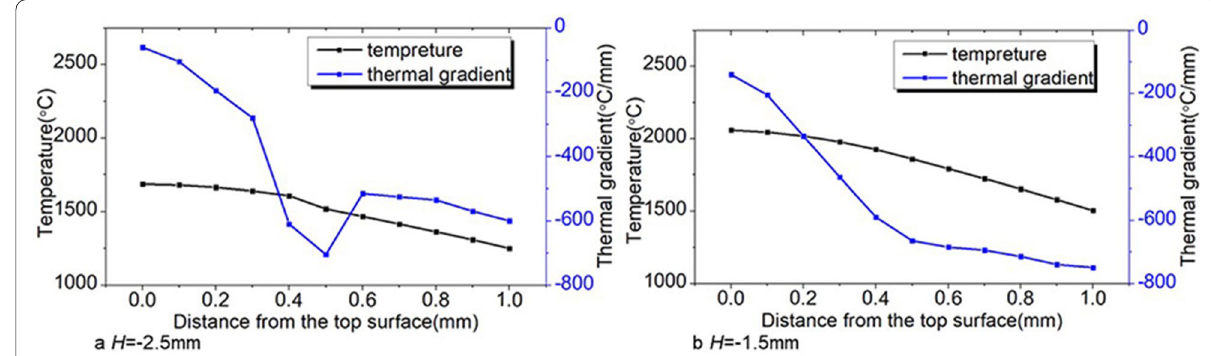
Figure 21 Thermal gradient: a H